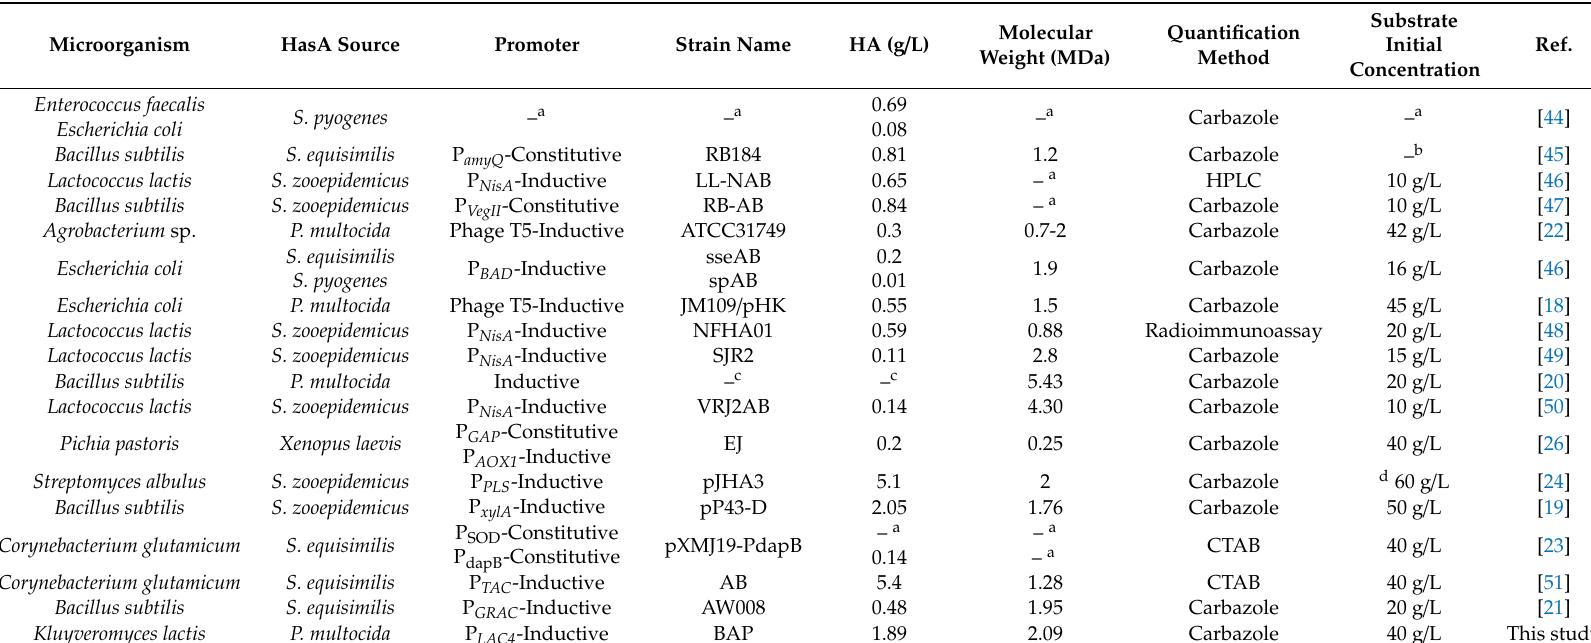
Table 4. Engineered microorganisms for HA production, strain construction strategy, HA titers, and molecular weight. Only recombinant strains containing hasA and hasB genes were considered